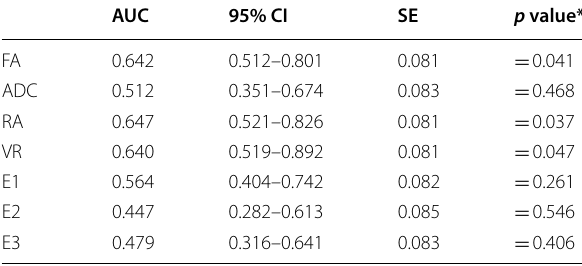
AUC, area under the curve; SE standard error, CI confidence interval *Null hypothesis: true area =